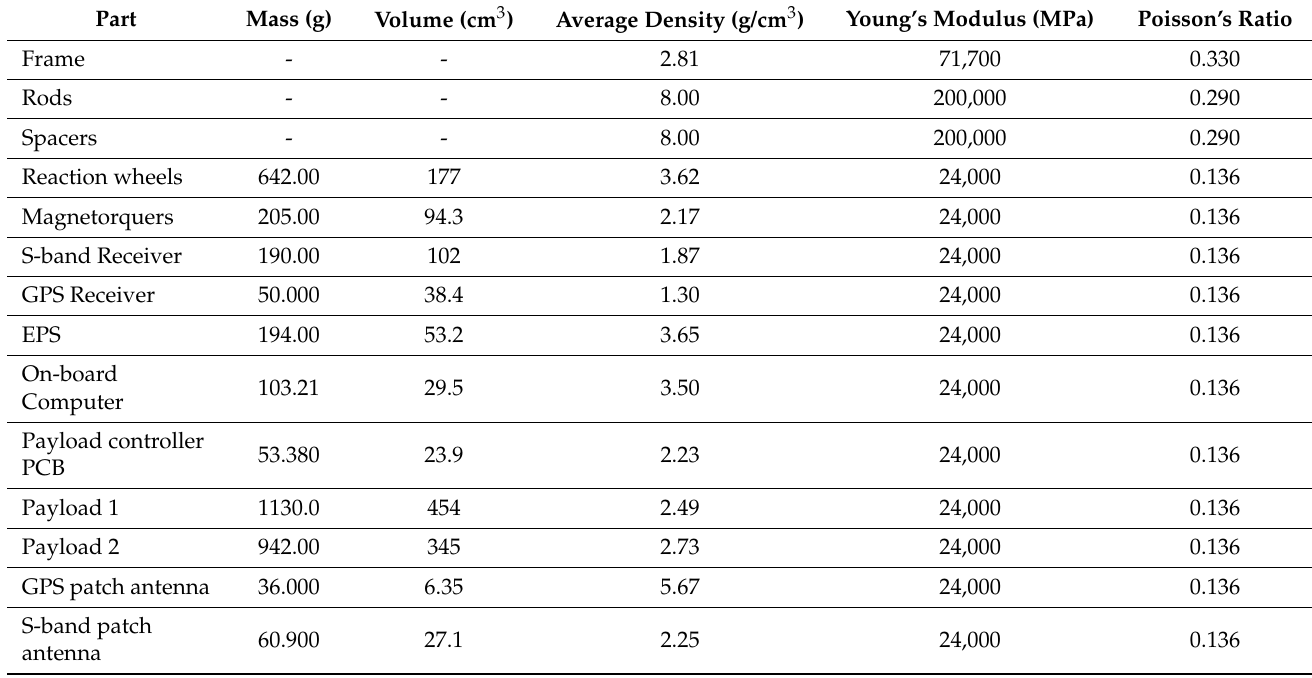
Figure 12. Simplified model of Light-1. Table 10. Material properties